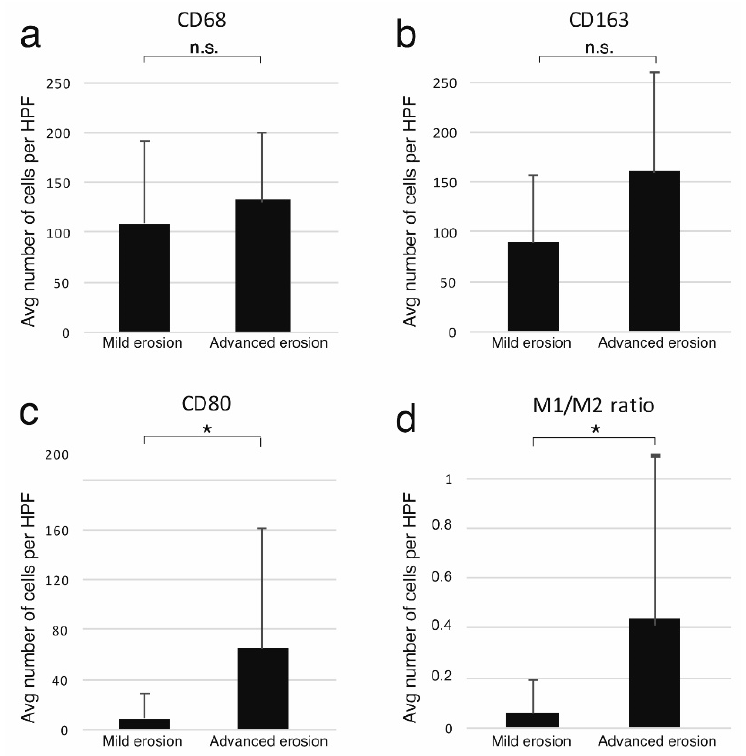
Figure 2. Bar graph illustration of the average number of marker-positive cells per high-power field (HPF). The bars represent the average of 28 specimens, and the error bars represent one